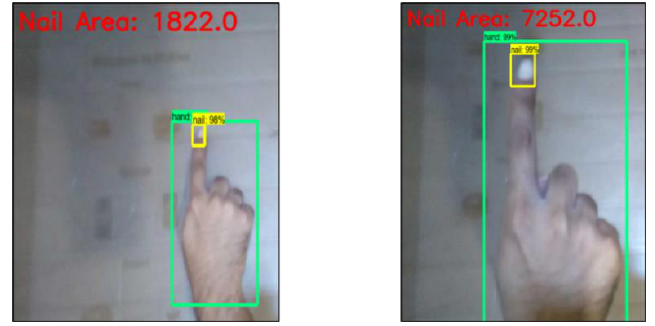
Fig. 18. Nail Area (a) Touching the table (b) Hovering above the